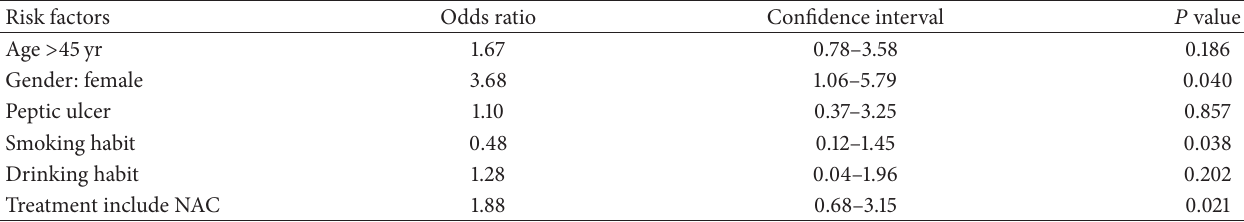
Table 3: Logistic regression analysis of risk factors for eradication of H. pylori